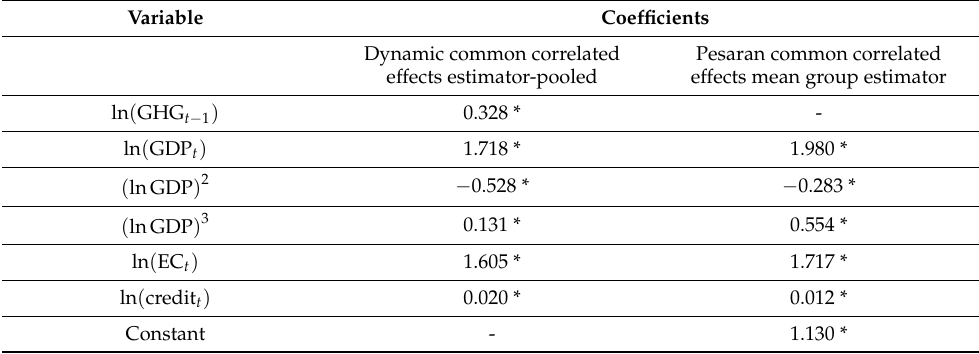
Table 9. Dynamic and Pesaran common correlated effects estimators to explain GHG emissions in EKC (basic